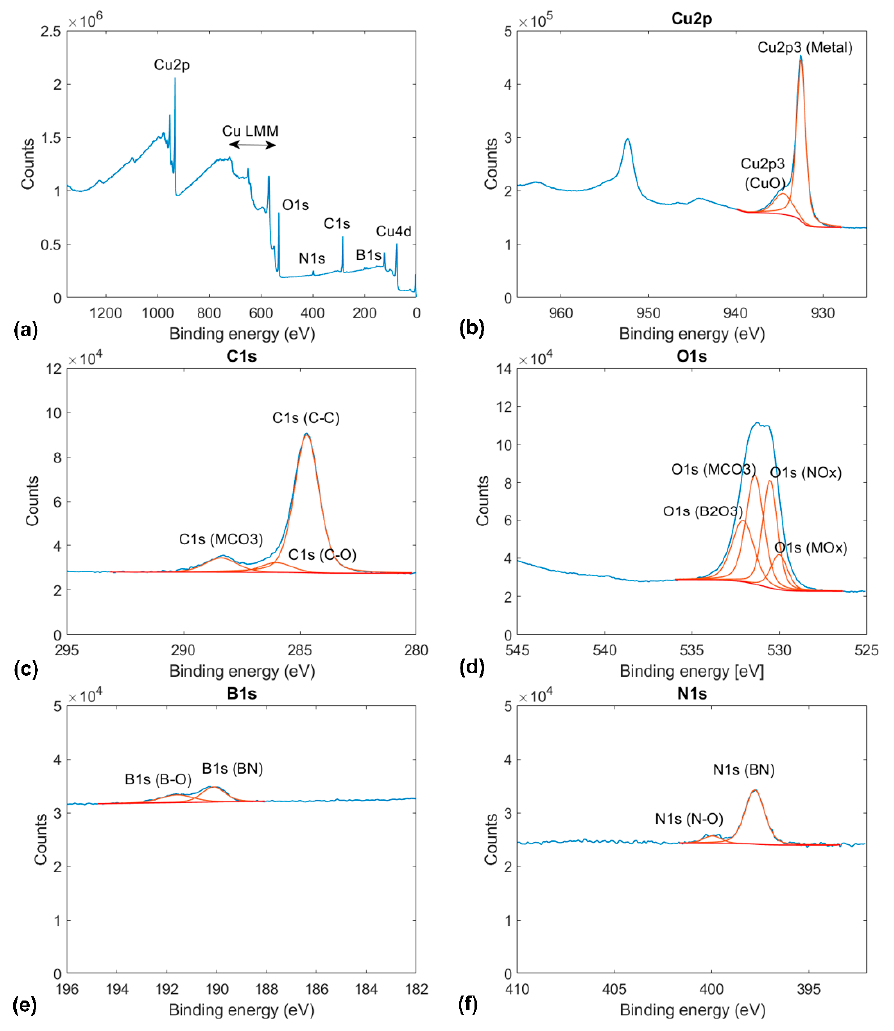
Figure 3. Indexed XPS results for boron nitride on copper: ( a ) full x-ray photoelectron spectrograms and spectrograms for the ( b ) Cu2p, ( c ) C1s, ( d ) O1s, ( e ) B1s, and ( f ) N1s orbitals.